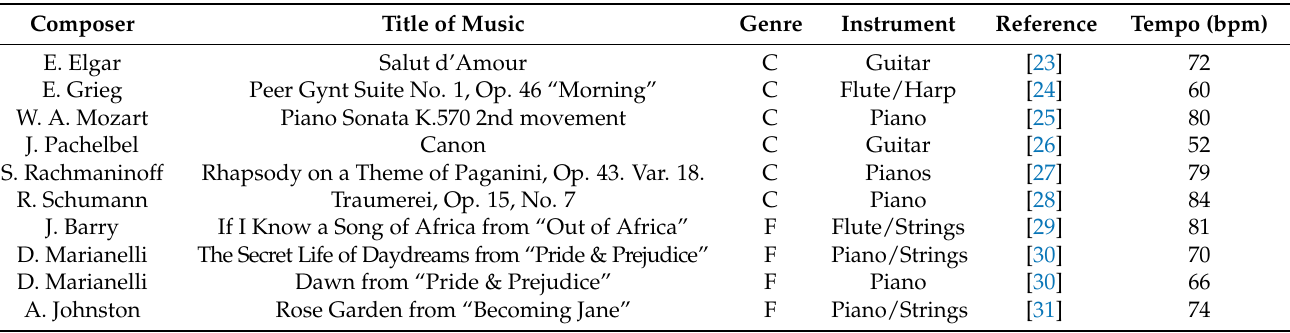
Table 1. List of selected